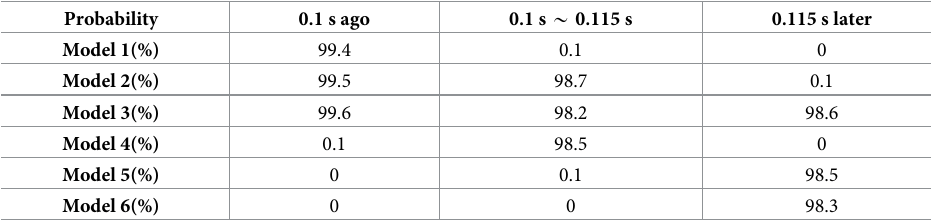
Table 7. Comparison of probability of matching models under simulation with multiple failures occurring in sequence. Probability